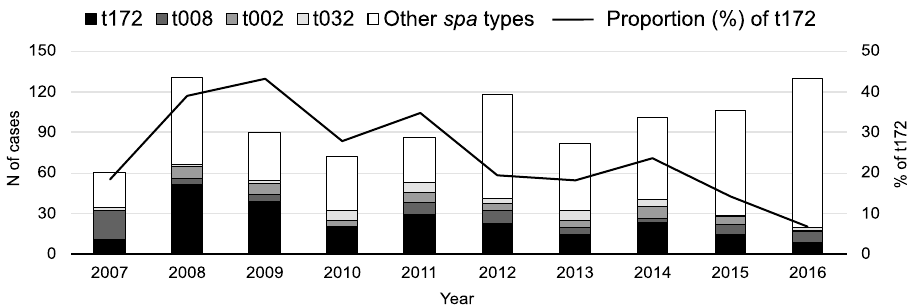
Figure 1. Annual number of MRSA cases caused by the four most common or other spa types and the proportion of t172, Hospital District of Southwest Finland, years 2007–2016 (n = 976).